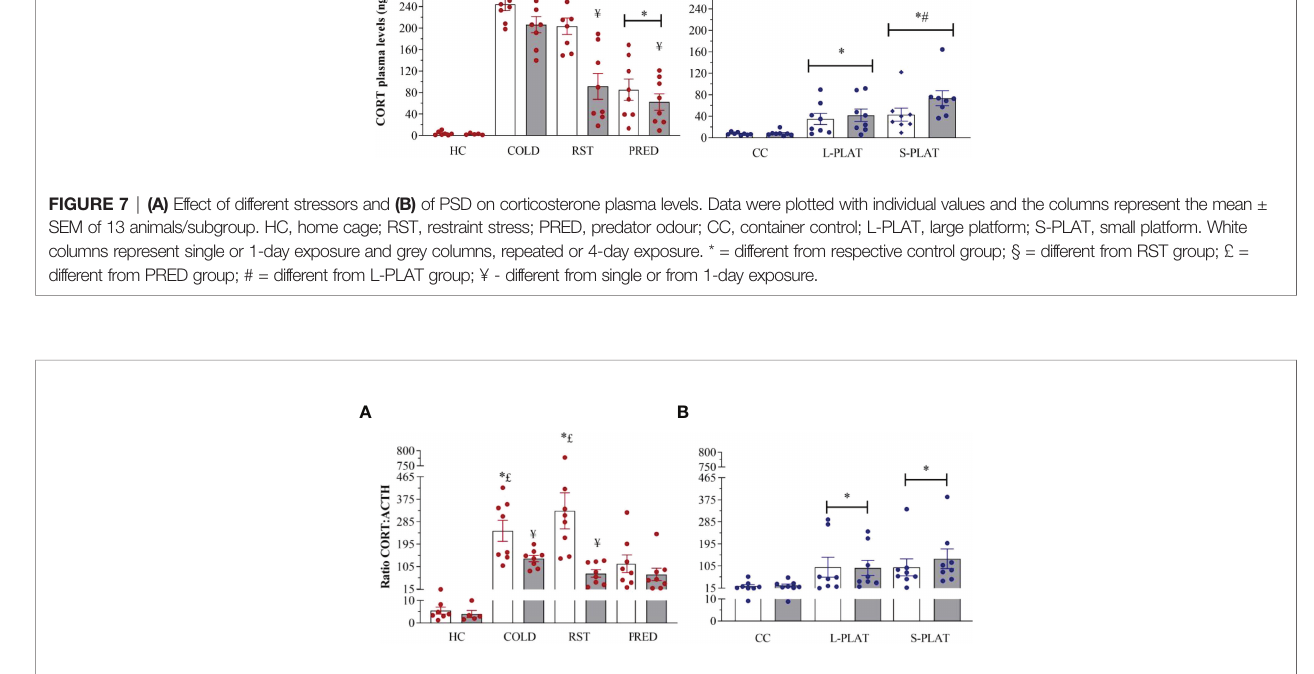
FIGURE 8 | (A) Effect of different stressors and (B) of PSD on CORT : ACTH ratio. Data were plotted with individual values and the columns represent the mean ± SEM of 13 animals/subgroup. HC, home cage; RST, restraint stress; PRED, predator odour; CC, container control; L-PLAT, large platform; S-PLAT, small platform. White columns represent single or 1-day exposure and grey columns, repeated or 4-day exposure. * = different from respective control group; § = different from RST group; £ = different from PRED group; # = different from L-PLAT group; ¥ - different from single or from 1-day